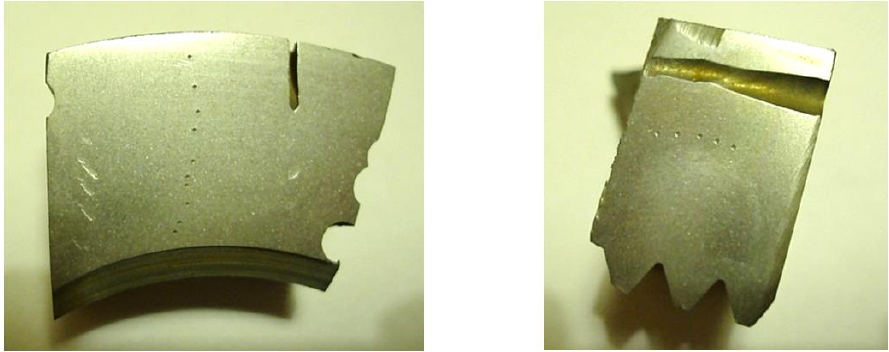
Figure 4. Hardness measurements at the site of the guide bar crack in both directions.